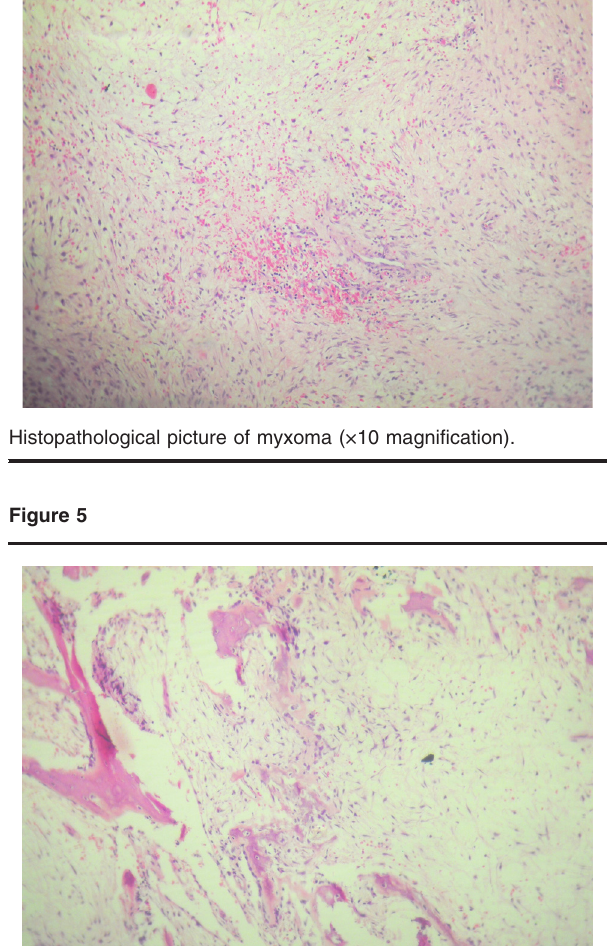
Postoperative facial palsy.